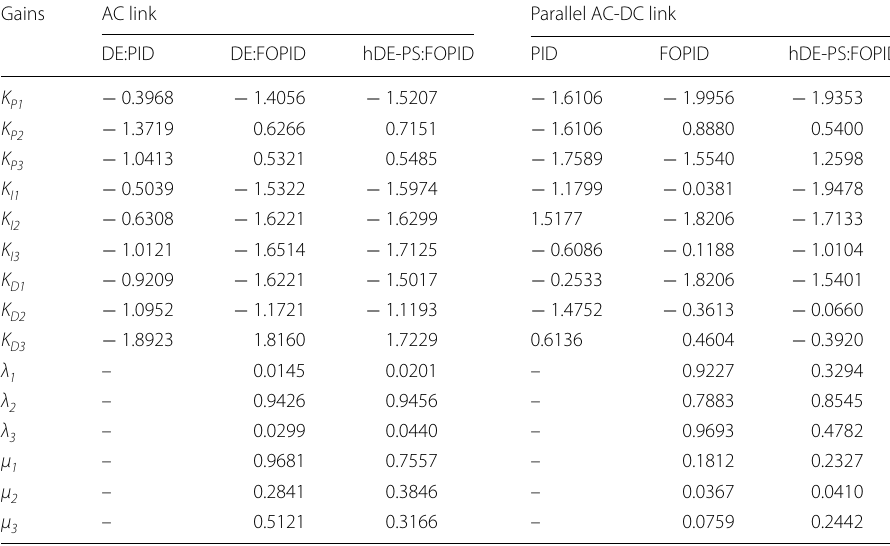
Table 2 Optimized PID/FOPID controller